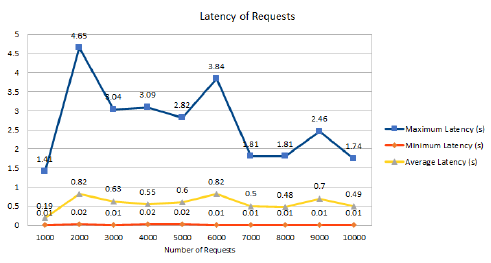
Figure 8. The latency of the request data functions.